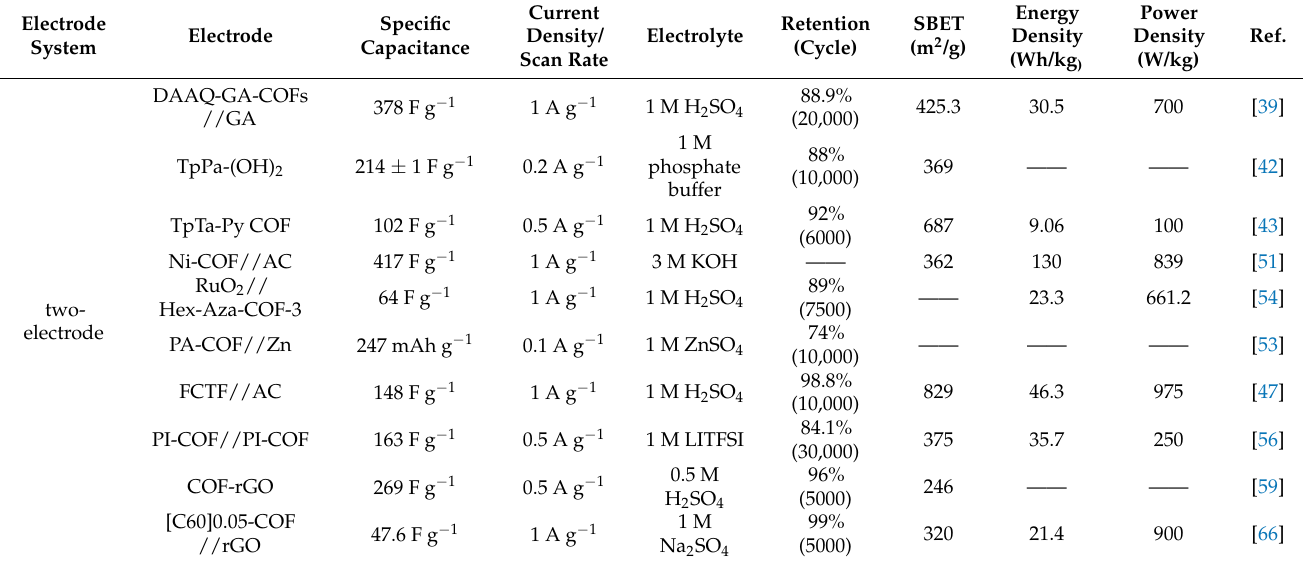
Table 2. COF-derived electrode materials and their electrochemical performance in practical device (two-electrode